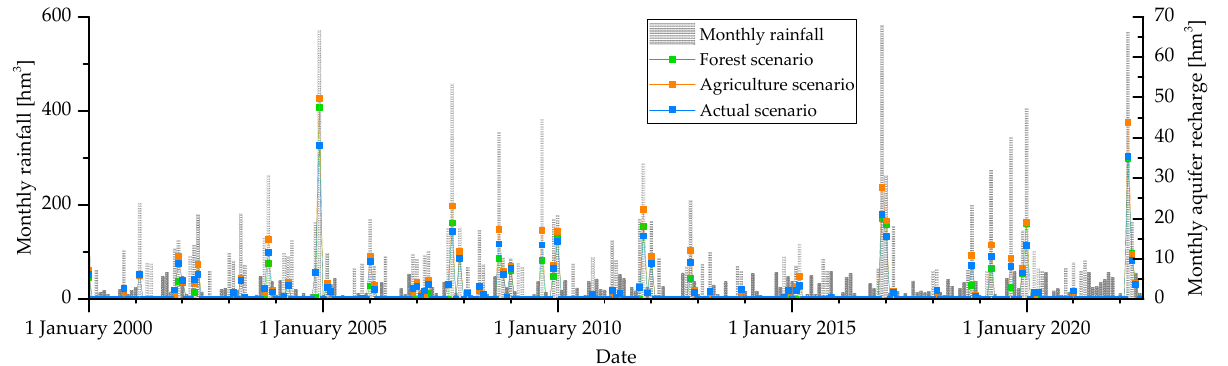
Figure 6. Monthly discretization of rainfall and aquifer recharge, for each land cover scenario from 2000 to 2022.